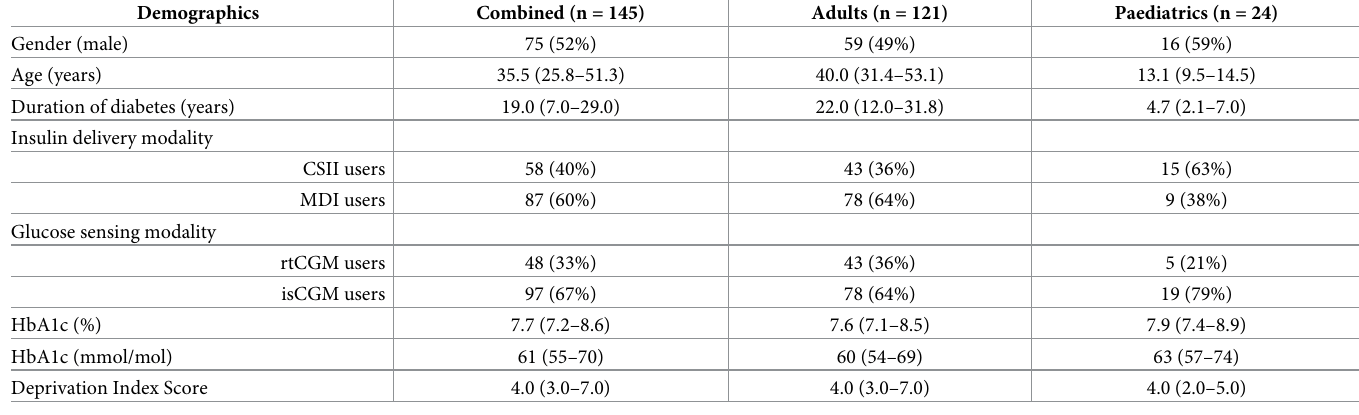
Results are expressed as median (IQR)/ n